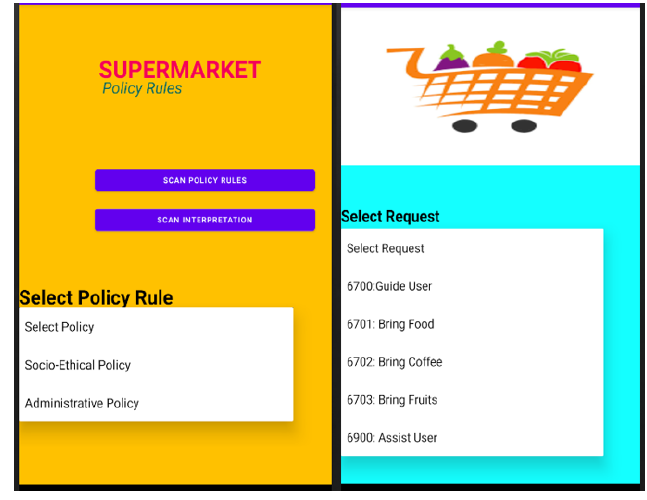
Figure 4. Administrator App ( Left ), Mediator App ( Right